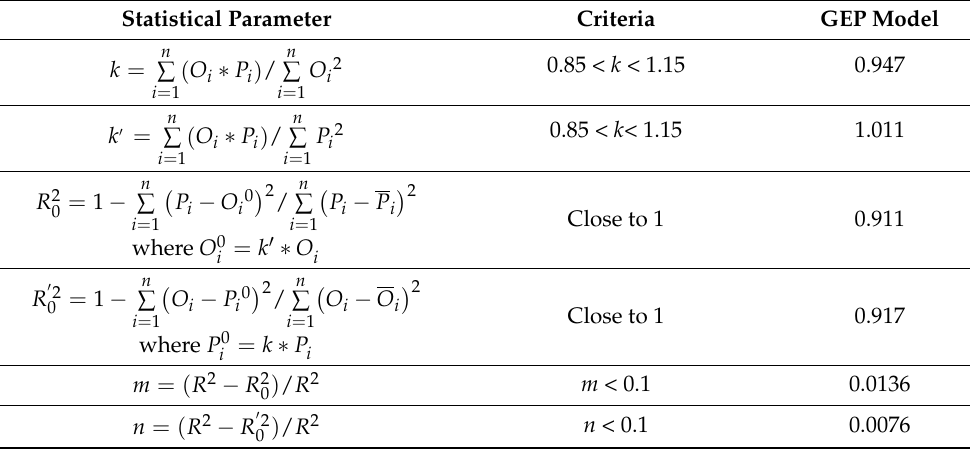
Table 5. Statistical parameters for the external validation of the selected GEP model.